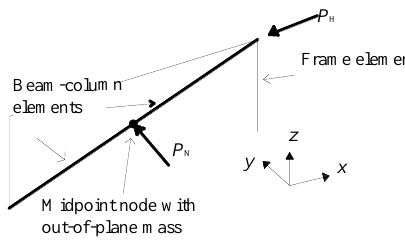
Figure 9. Simulation of infill walls [10].